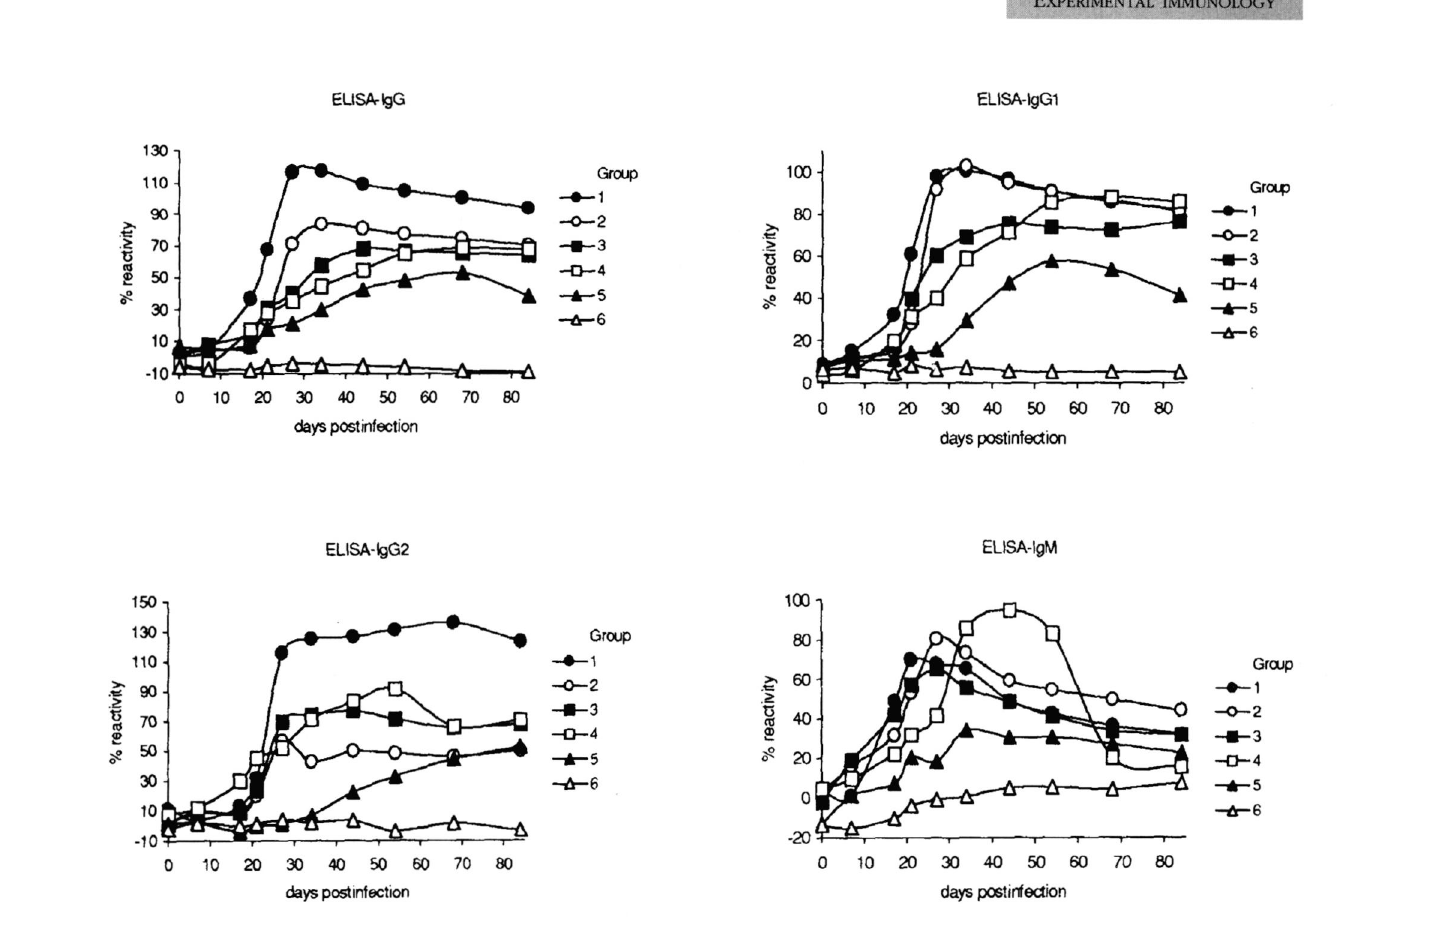
Fig. 3- - Kinetics of specific IgG, IgG1, IgG2 and IgM antibodies by ELISA in pigs infected with different levels of infection of T. spiralis (groups 1, 2, 4 and 5), T. britovi (group 3) and non infected pigs (group 6) against crude and ES antigens of both